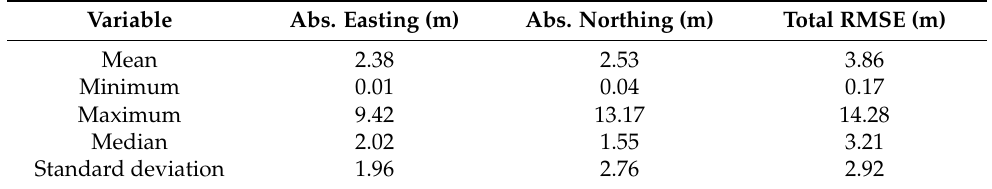
Table 5. Reported absolute (Abs.) georeferencing errors for the data acquired on 2 August (F-03) at the longest integration time of 1.4 ms to the baseline imagery collected at an integration of 1.4 ms on 3 August (F-04) during the 2017 campaign over the SLK-37 site. Variable Abs. Easting (m) Mean Minimum Maximum